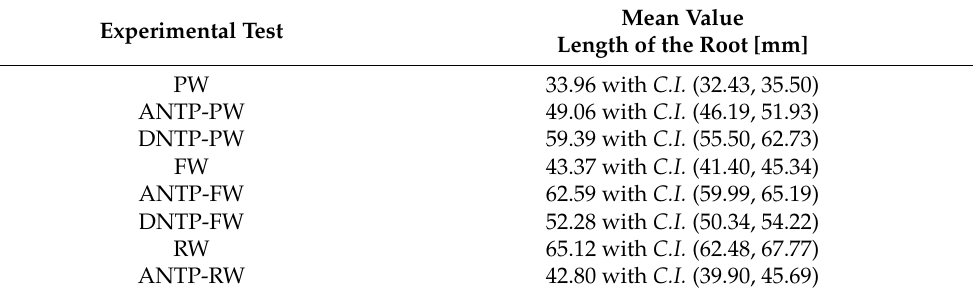
Table 1. Length of the root of lentil plants in experimental tests.